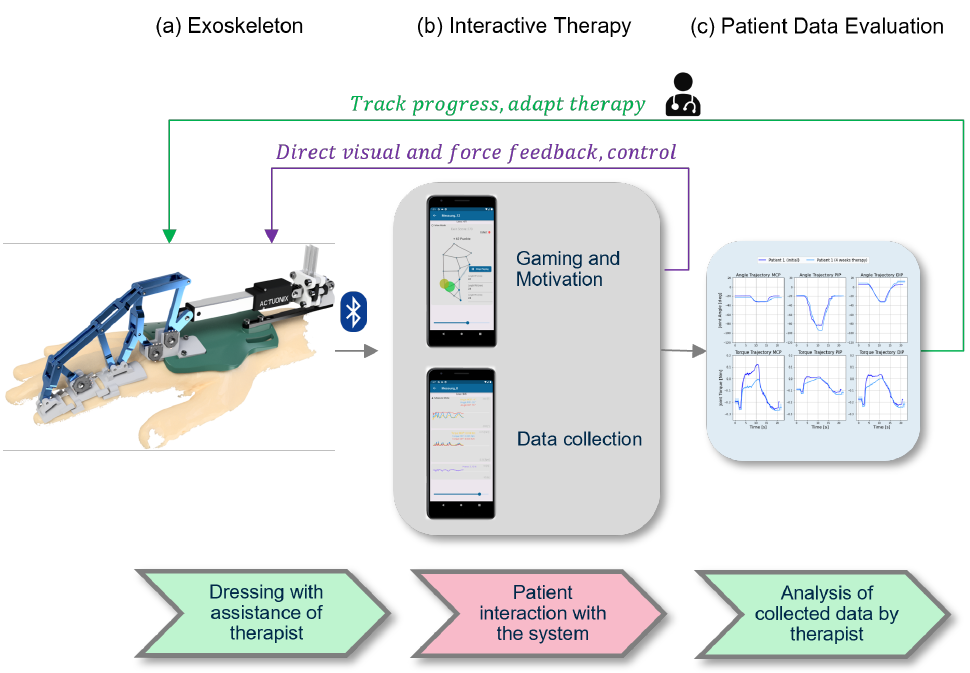
Figure 2. Overview of the workflow of the exoskeleton and the app. The exoskeleton from Dickmann et al. [18] in ( a ) is connected to the app via Bluetooth and enables games and data acquisi- tion ( b ). The received data can be used for therapy or progress assessment ( c